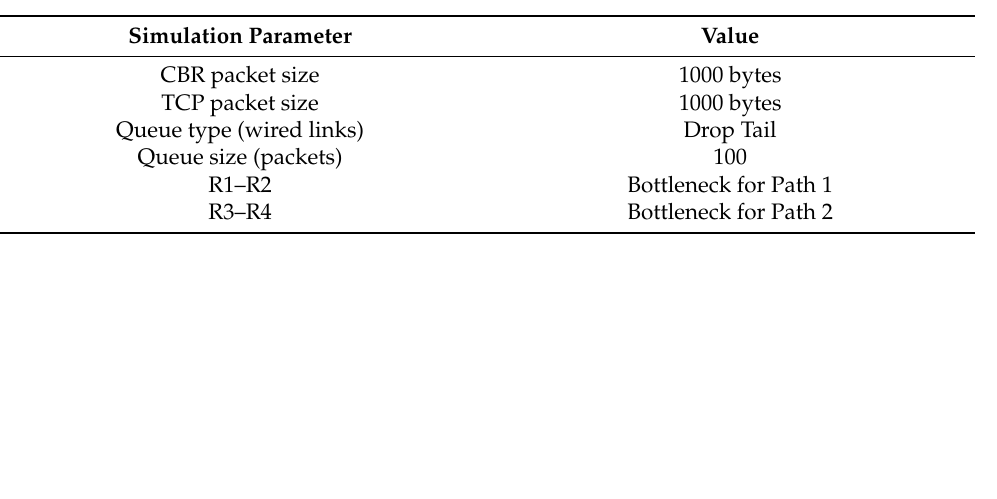
Figure 5. Aggregate throughput of CBR traffic when source node “S” is using MPTCP with coupled congestion control linked-increases algorithm (MPTCP-CC-LIA). Table 4. Simulation parameters for wired